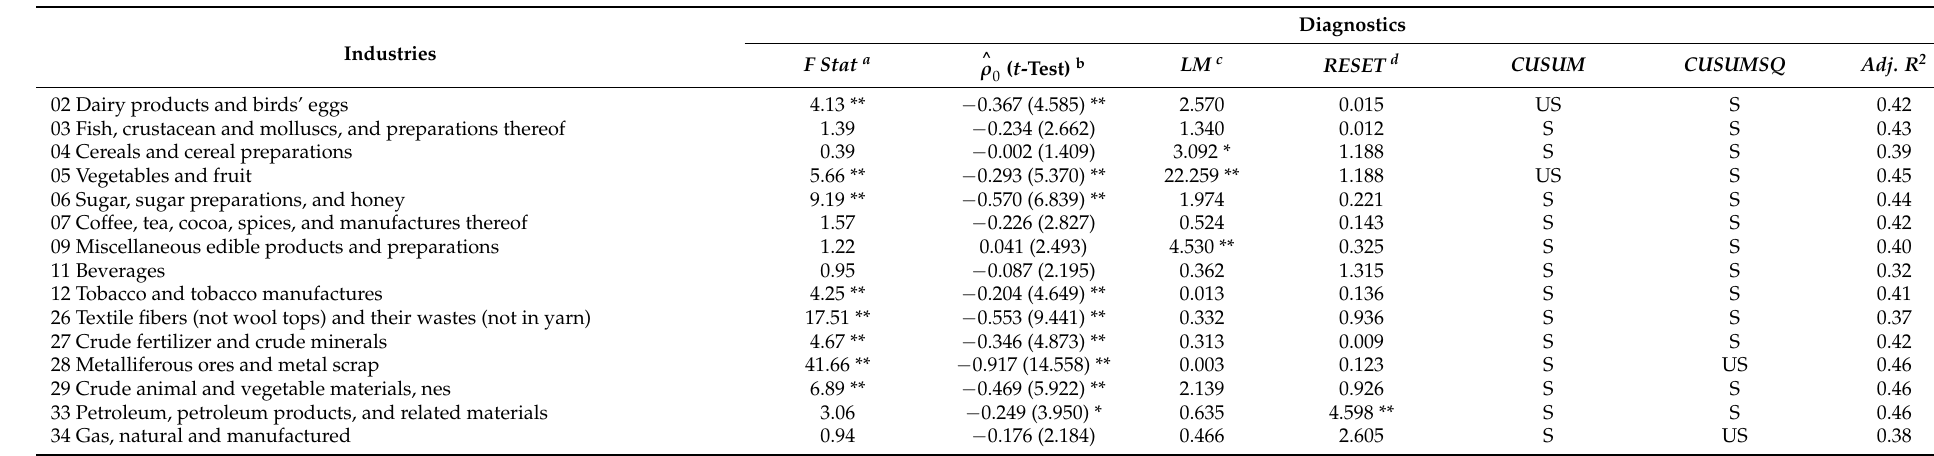
Table 8. Diagnostic statistics associated with U.S. import